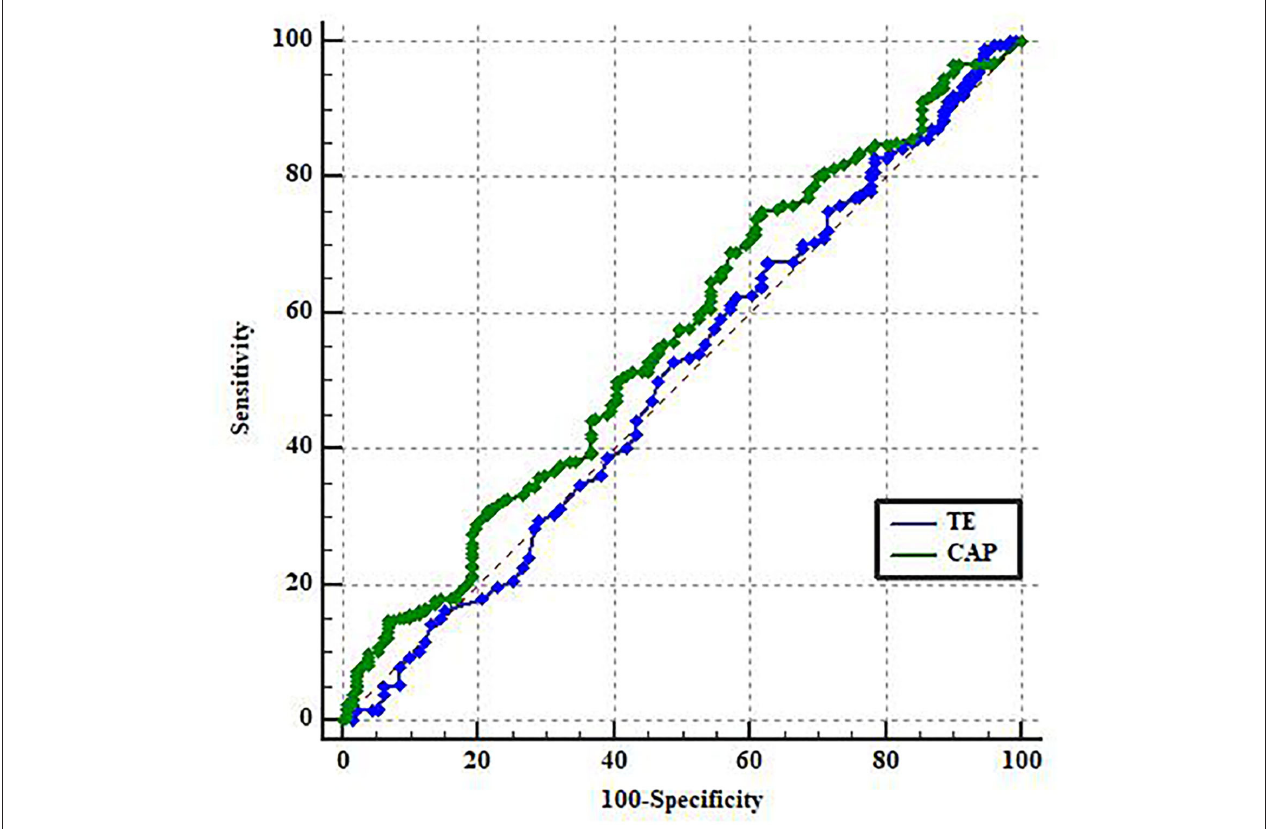
FIGURE 2 | ROC curve for predicting